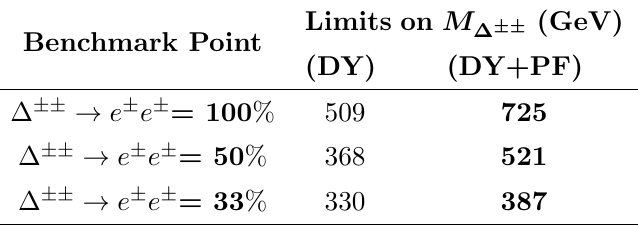
Table 4 . Summary of the 95% CL exclusion limits on M with 13.9 fb (cid:0) 1 integrated luminosity. DY: Drell-Yan pair production; PF: photon fusion